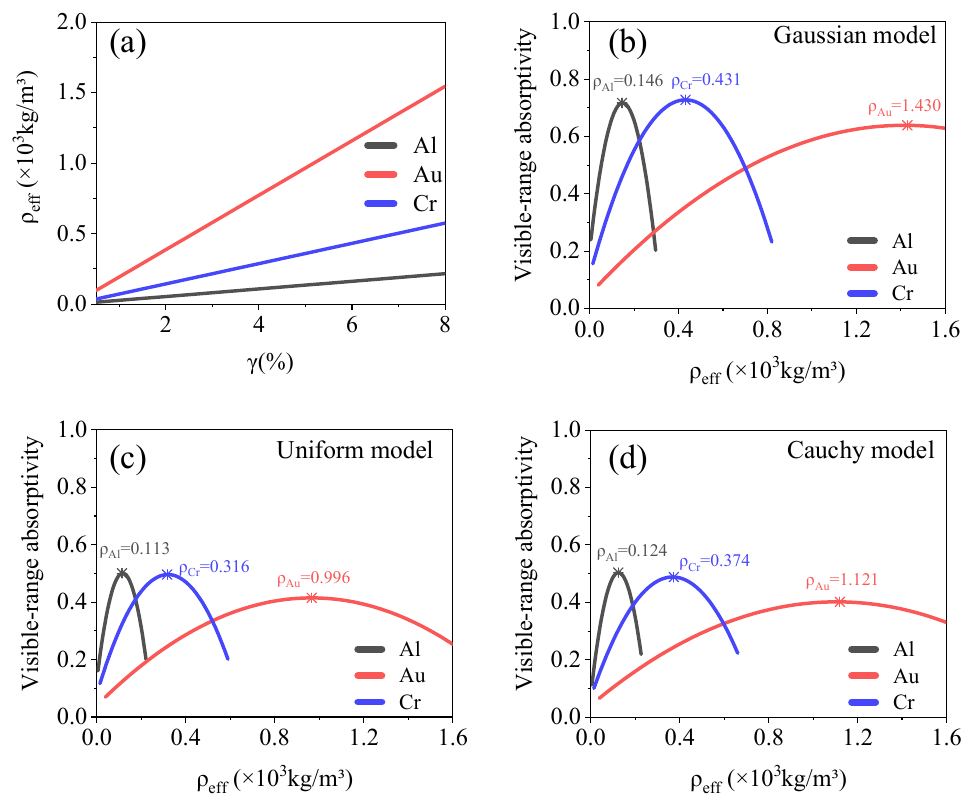
Figure 7. ( a ) Relationship between filling factor and equivalent density of model used. ( b – d ) Relationship between equivalent density and visible absorptivity for Gaussian, uniform, and Cauchy models. Equivalent density of model with maximum absorptivity is marked in the figures.